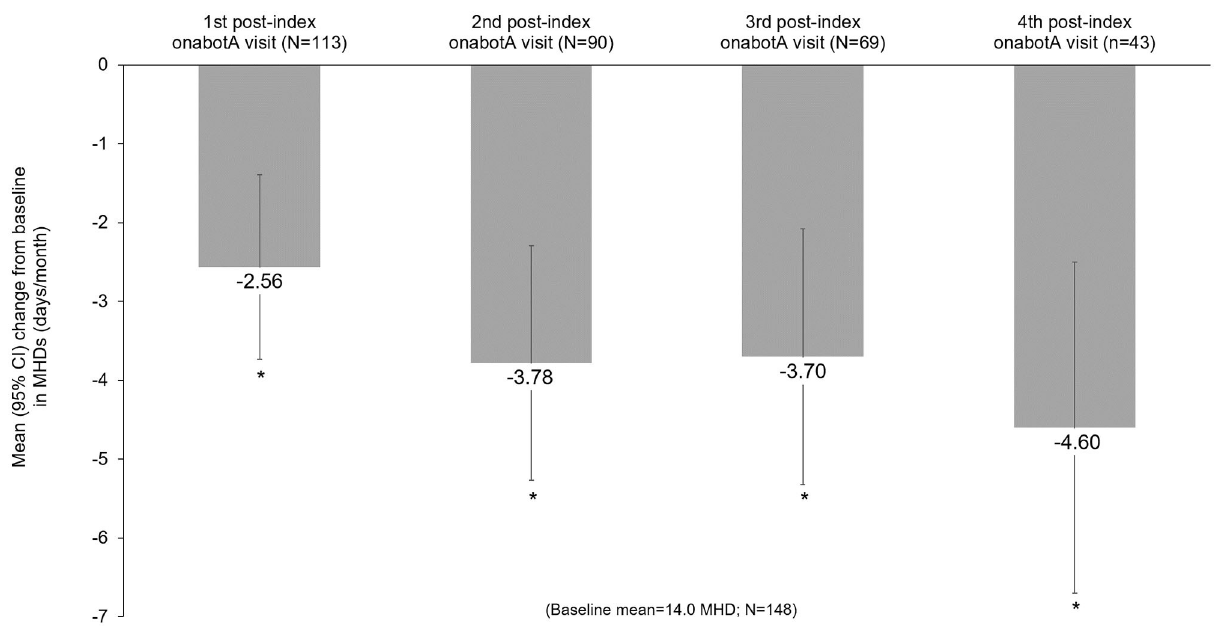
FIGURE 3 | Mean change from baseline in monthly headache frequency during combination treatment with onabotulinumtoxinA and a CGRP mAb. CGRP, calcitonin gene-related peptide; CI, confidence interval; CM, chronic migraine; mAb, monoclonal antibody; MHD, monthly headache days; onabotA, onabotulinumtoxinA. *Indicates statistical significance (i.e., 95% CI does not include